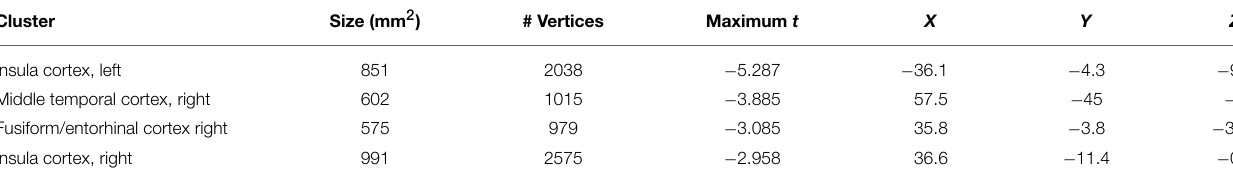
TABLE 4 | General linear model results regarding number of mTBI and CT in the mTBI group. Cluster Size (mm 2 ) # Vertices Maximum t X Y Z Insula cortex, left 851 2038 − 5.287 − 36.1 − 4.3 − 9.5 Middle temporal cortex, right 602 1015 − 3.885 57.5 − 45 − 8 Fusiform/entorhinal cortex right 575 979 Insula cortex, right 991 2575 − 2.958 36.6 − 11.4 −